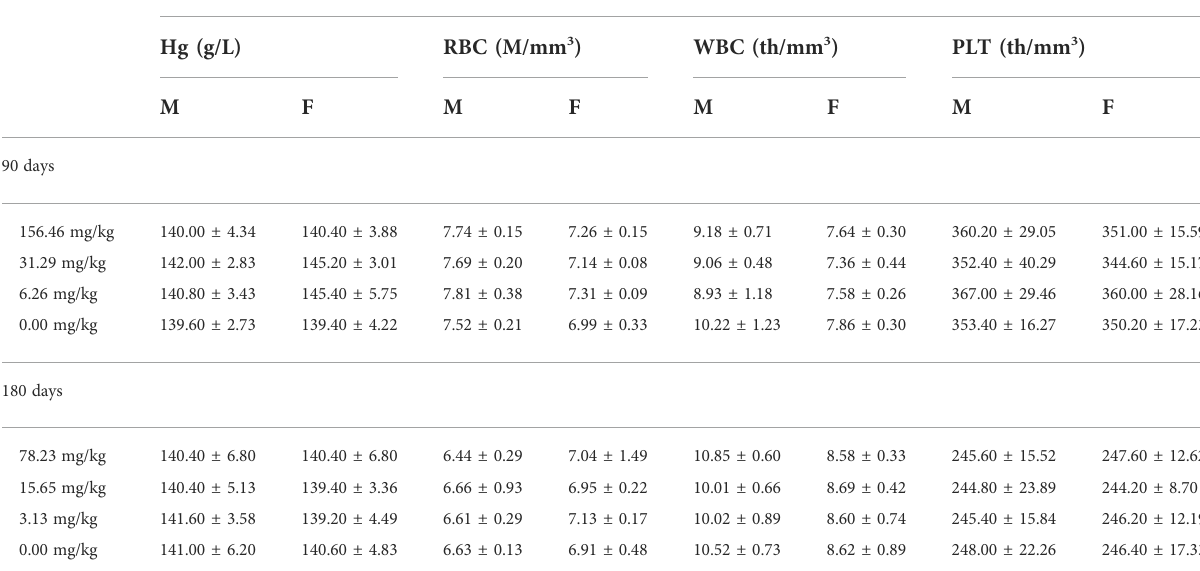
TABLE 3 Effect of feeding MCE for 90 and 180 days on hematological parameters in rats.